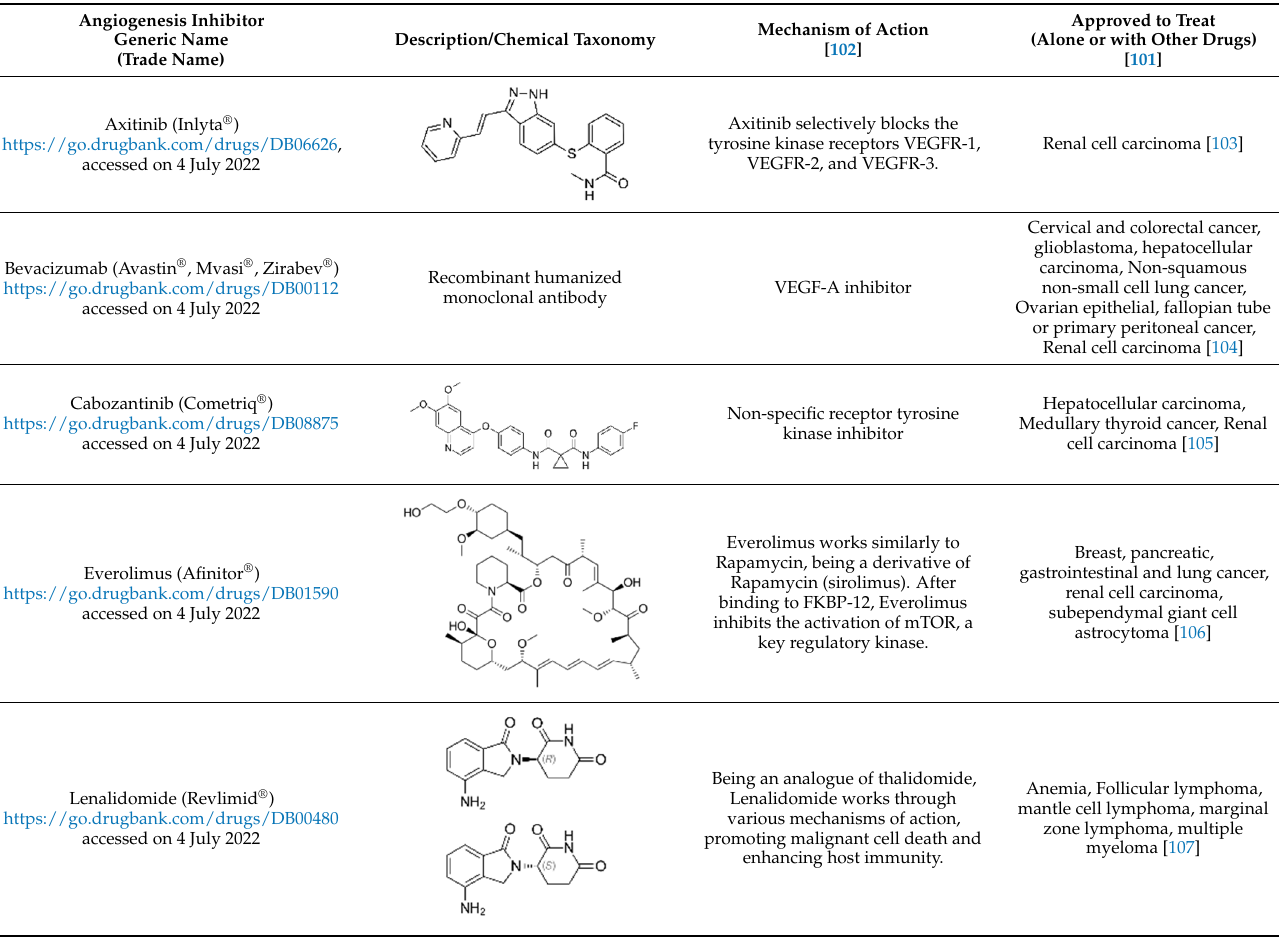
Table 3. Angiogenesis inhibitors approved to treat cancer in humans.